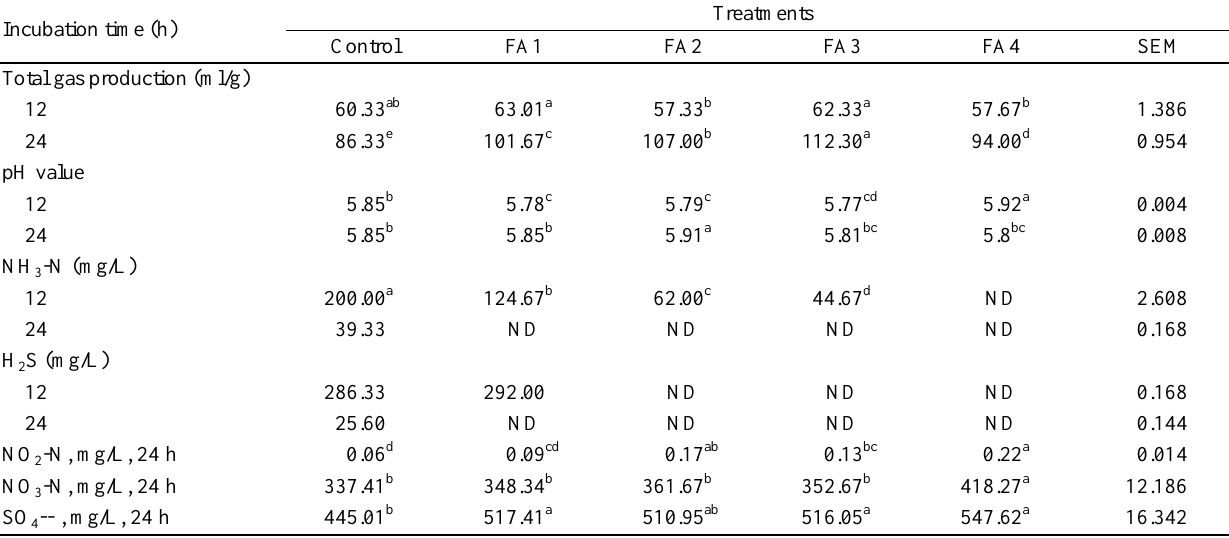
Table 2. Total gas production, pH, ammonia-nitrogen (NH 3 -N), hydrogen sulfide (H 2 S), nitrite-nitrogen (NO 2- -N), nitrate-nitrogen (NO 3- -N) and sulfate (SO 4-- ) concentrations of in vitro fermented swine fecal slurry added with soybean meal and different phytogenic feed